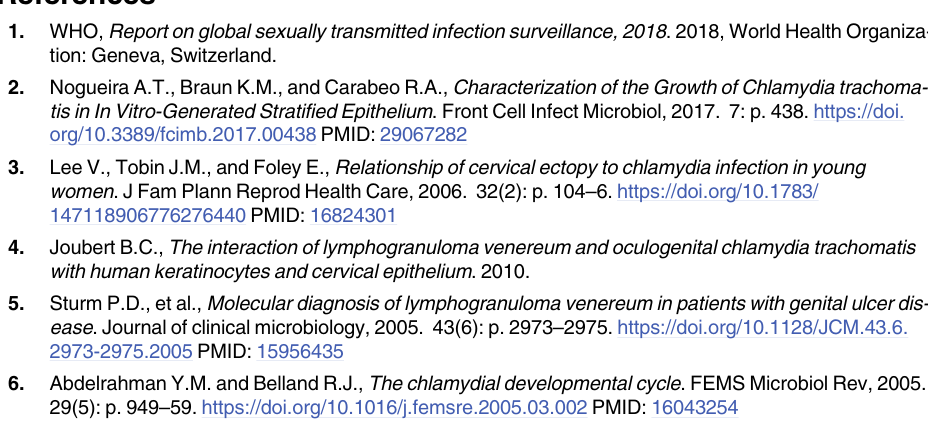
S1 Table. Processing schedule for TEM. S2 Table. Mean fold changes for six chlamydial genes in HaCaT